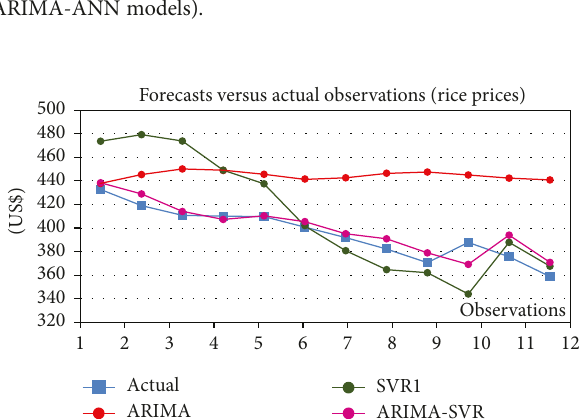
, and the proposed 1